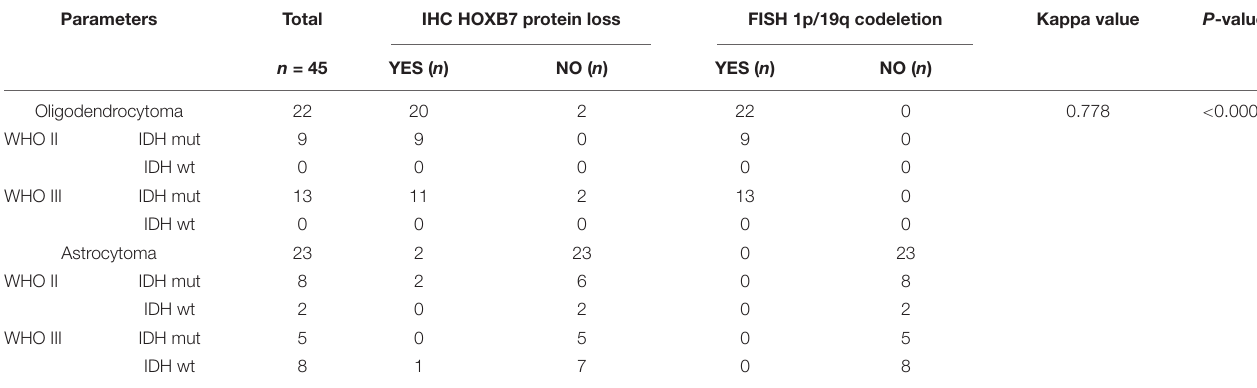
TABLE 2 | Consistency test between 1p/19q Codeletion and HOXB7 protein loss in LGG. Parameters Total IHC HOXB7 protein